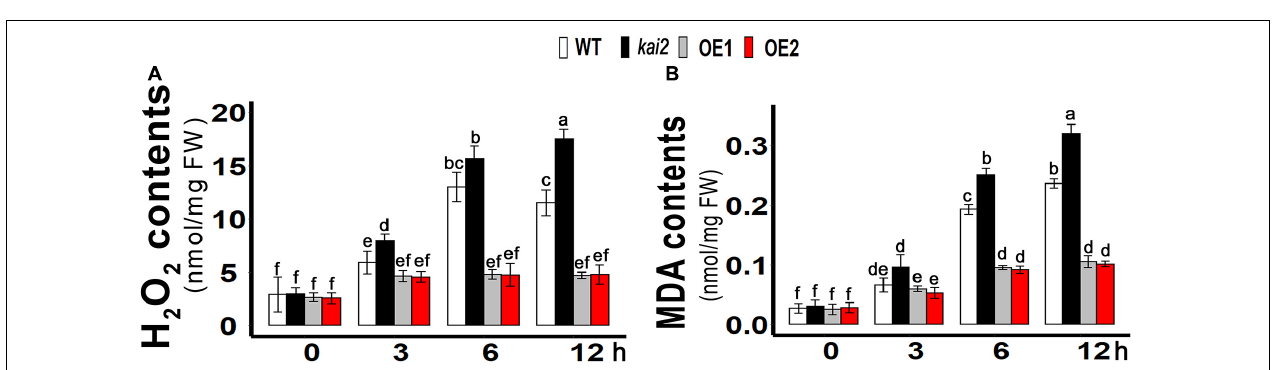
FIGURE 3 | Overexpression of SsKAI2 promoted TSS and TSP under cold stress. (A) Total soluble sugars. (B) Total soluble protein contents. (C) Proline contents. Twenty-five-day-old plants were subjected to cold treatment. The samples were taken randomly from the leaves of three plants of each independent [(wild-type (WT), Atkai2 , KAI2 over-expressed line 1 (OE1) and line 2 (OE2)] line after 3 − , 6 − , and 12 h under cold treatment (4 ◦ C). One-way ANOVA was used to analyzed all data, and HSD Tukey’s test was used to perform multiple comparisons at P < 0.05 significant level ( n = 3). An “h” at the X -axis of each graph represents time in hours under cold stress. Bars with uncommon letters showing significant difference at P < 0.05.